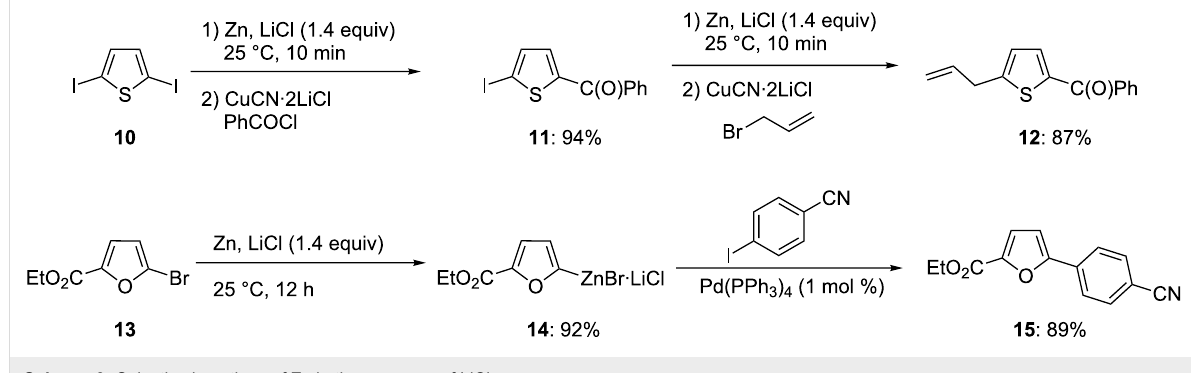
Scheme 3: Selective insertions of Zn in the presence of LiCl.